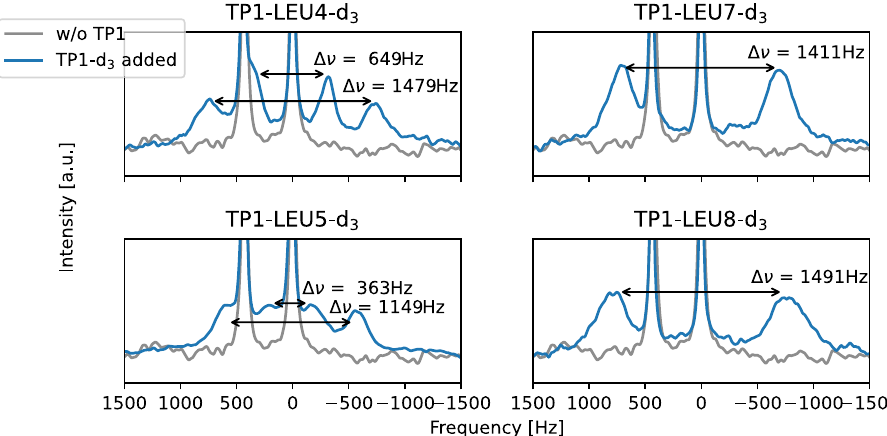
2 Figure 2. H-NMR spectra of TP1 peptide immersed in a SDS-based membrane mimetic. A different leucine is deuterium-labeled in each spectrum.